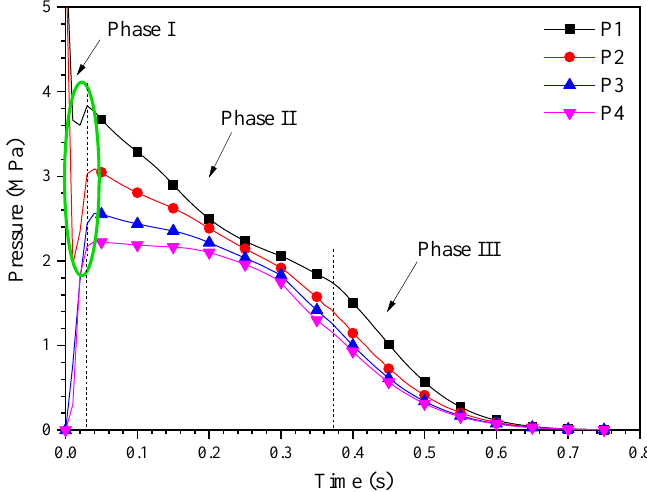
Figure 6. Pressure curves at different positions.